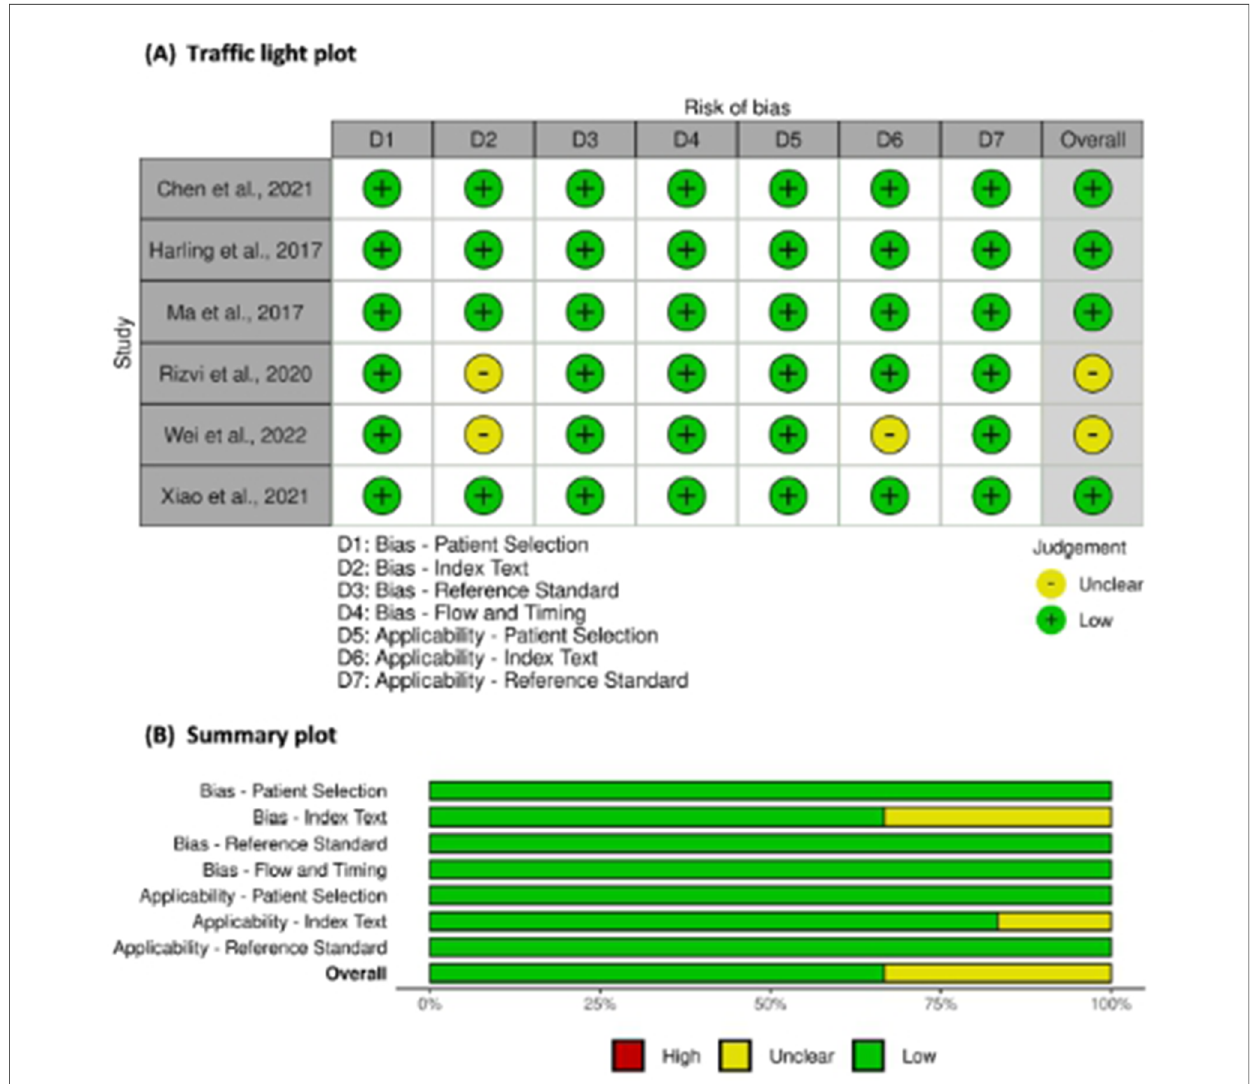
FIGURE 2 Risk of bias assessment of studies using QUADAS-2. ( A ) Traf fi c light plot and ( B ) Summary